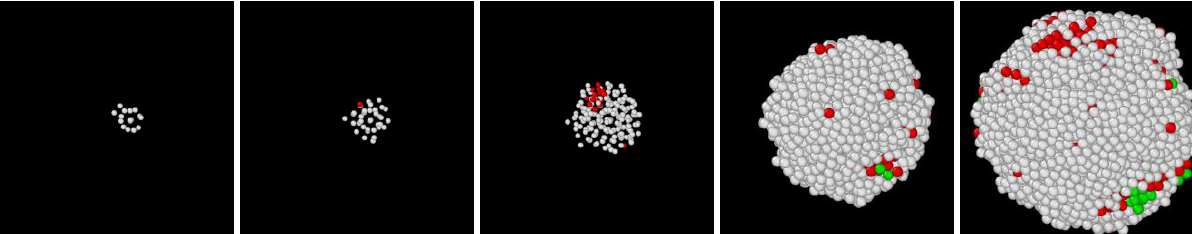
Figure 6. Snapshots of a solid cluster forming in an MPFC simulation performed under the same conditions as the simulation shown in Figure 5. In the left three panels, small spheres are used to indicate the position of the density peaks, which allows us to see the presence of an ordered but non-crystalline initial structure. On the right atom-size spheres are displayed. The snapshots were taken at dimensionless times t = 460, 500, 600, 900, and 1100. The same coloring is used as in Figure 3. A fraction of a 512 3 simulation is shown.